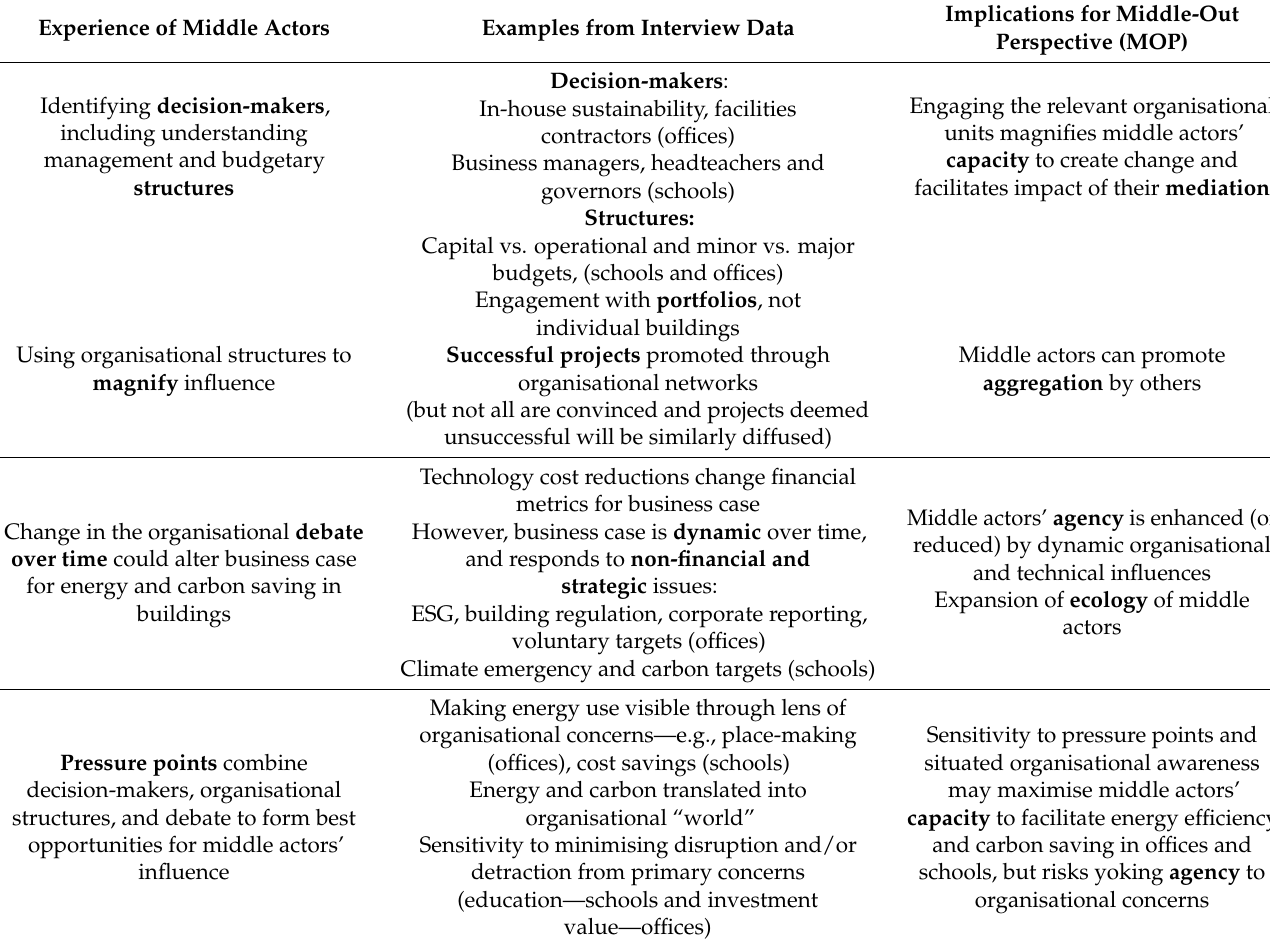
Table 3. Results and Discussion, showing links between middle actors’ experiences, supported by the interview data, and the implications for the Middle-Out Perspective